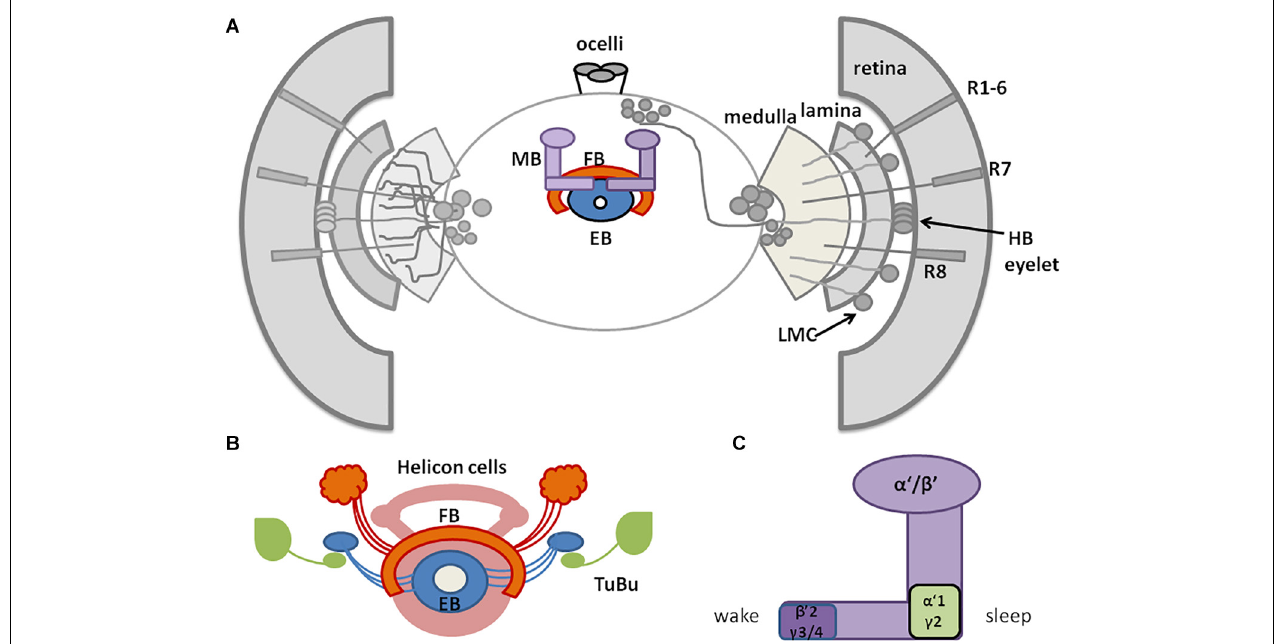
FIGURE 2 | A schematic representation of Drosophila sleep centers and structures mediating light signals. (A) Drosophila brain with three photoreceptive structures: visual system (composed of retina and three optic neuropils: lamina, medulla, and lobula), extra-retinal Hofbauer–Buchner (HB) eyelets and ocelli, located on the top of head. Light is received by retinal photoreceptors R1–6, which terminate in the lamina, and R7–8, terminating in the medulla and transmitting through lamina monopolar cells (LMC) to the deep brain. HB eyelets, located between retina and lamina, are sensitive to high intensity light and transmit signal directly to clock neurons (ventral-lateral neurons_LNvs). In the central brain sleep centers are located with mushroom bodies (MB), ellipsoid body (EB), and fan-shaped body (FB). (B) Scheme of sleep center, composed of fan-shaped body (FB), mushroom bodies (MB), ellipsoid body (EB), and additional cells: tubercular bulbar neurons (TuBu) and helicon cells. (C) Mushroom bodies are composed of vertical ( α , α ’) and horizontal ( β , β ’, γ ) lobes. Wake-promoting neurons are located in β ’2, γ 3/4, while sleep-promoting ones in α ’1, γ 2 region of